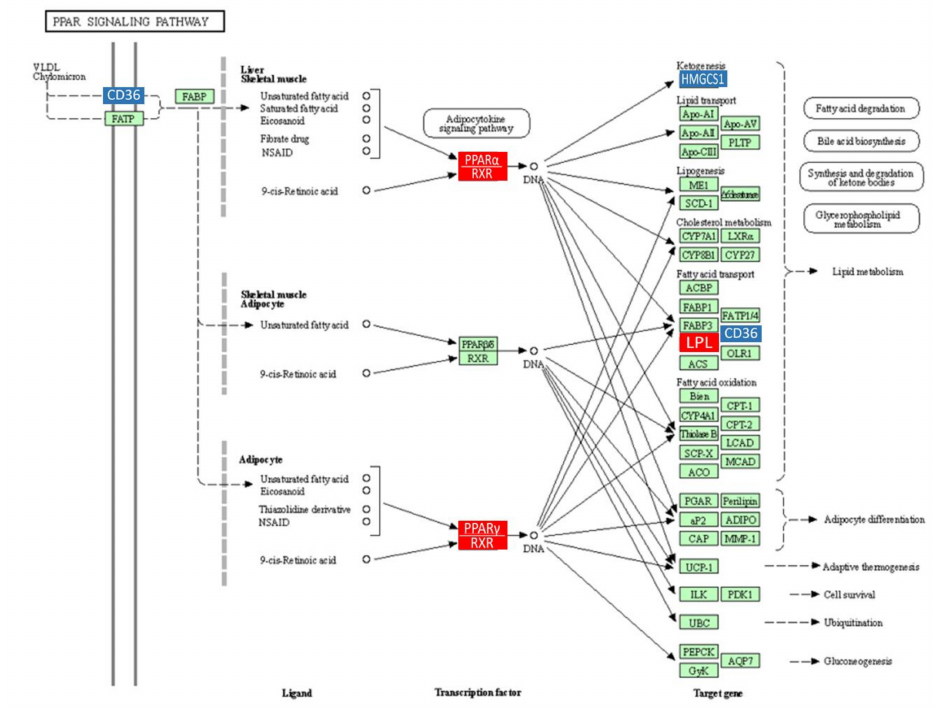
Figure 7. KEGG network diagram of the PPAR-signaling pathway. Red indicates up-regulated genes, blue indicates down-regulated genes, and green indicates genes that were not changed